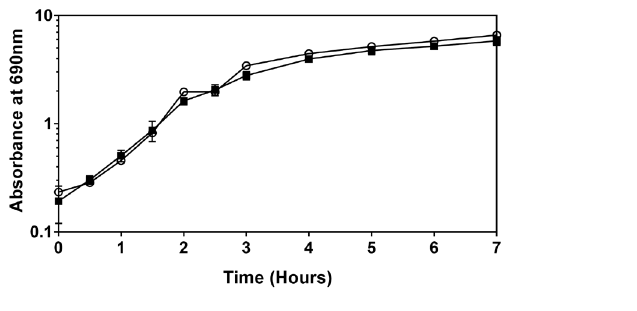
Figure 3. Growth comparison of supplementation with sub- MIC levels of Virukill (●) and without Virukill ( ○ ): ( a ) Serratia marcescens ATCC 13880; ( b ) Serratia sp. HRI.